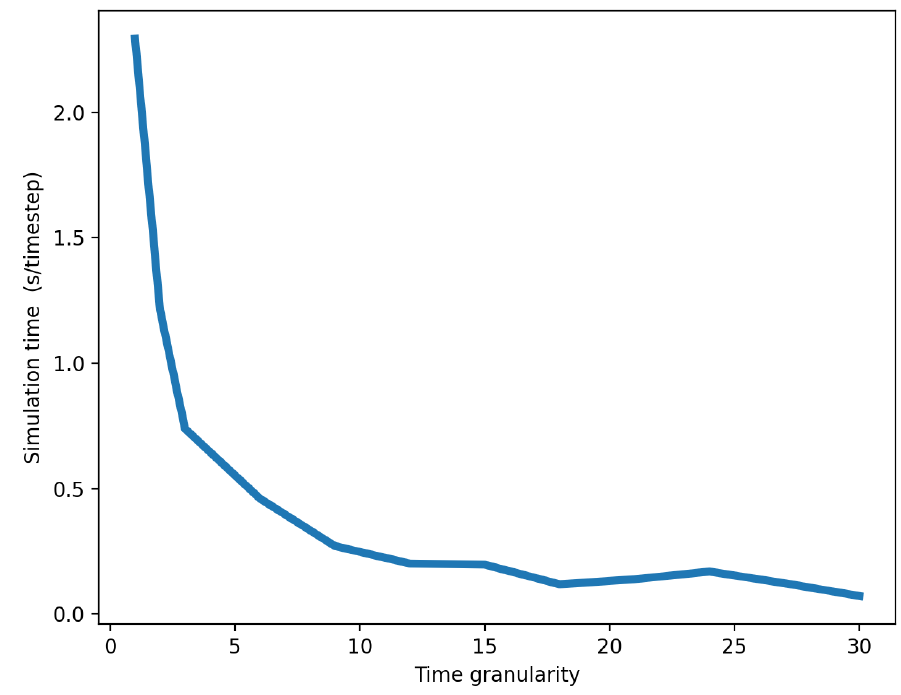
Figure 9. Inverse relationship that leads to trade-off between simulation time and accuracy, controlled by time granularity.